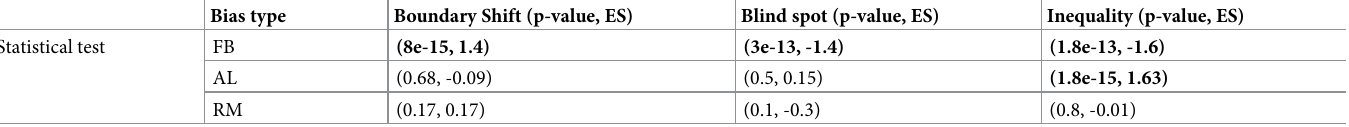
Table 14. Experimental results with a 10D synthetic data set. The effect size is calculated by ( Measurement | t = 0 − Measurement | t = 200 )/ std ( � ). The measurements are the three metrics presented in Section Evaluating the Effect of Iterated Algorithmic Bias on Learning Algorithms 1. We report the paired t-test results. For filter bias mode (FB), the results are identical to those of the 2D synthetic data across all three research questions. Active learning bias (AL) generates the same result as for the 2D synthetic data. Random selection (RM) has no obvious effect, similarly to the 2D synthetic data